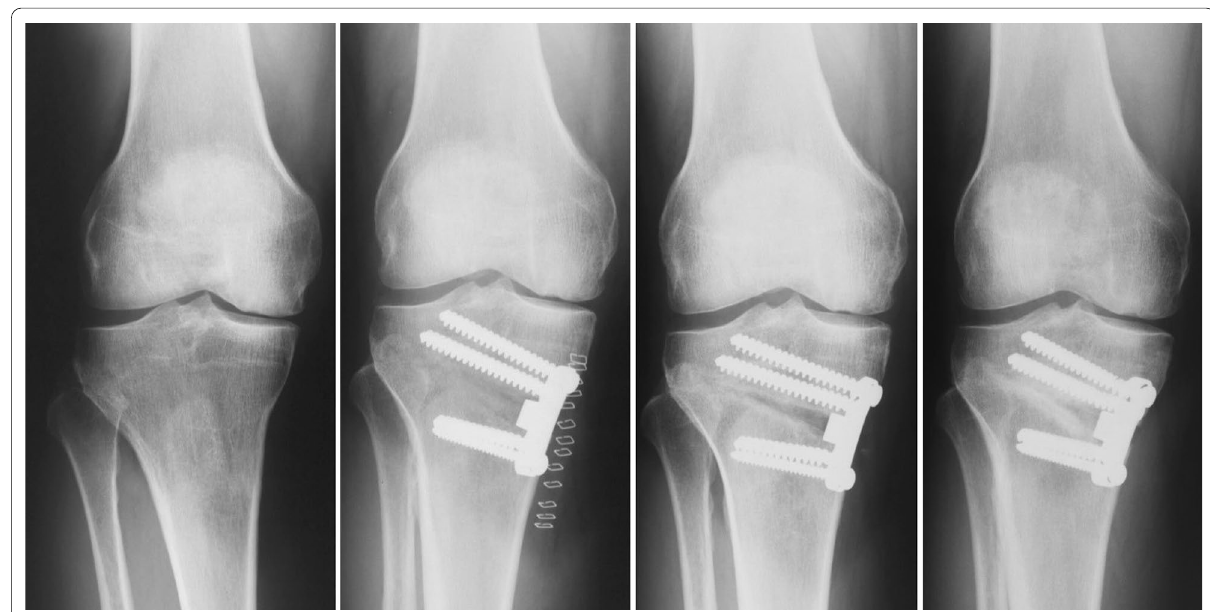
Fig. 10 Anteroposterior X-ray views of the same right knee. From left to right, respectively: preoperatively, and 1 day, 1 month, and 3 months